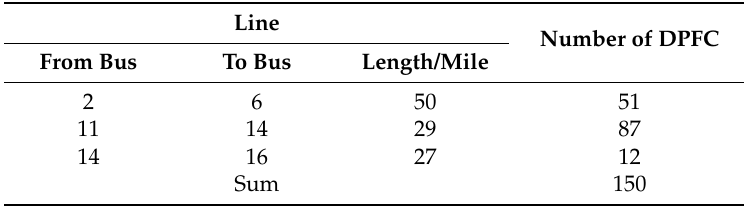
Table 2. Optimal configuration of